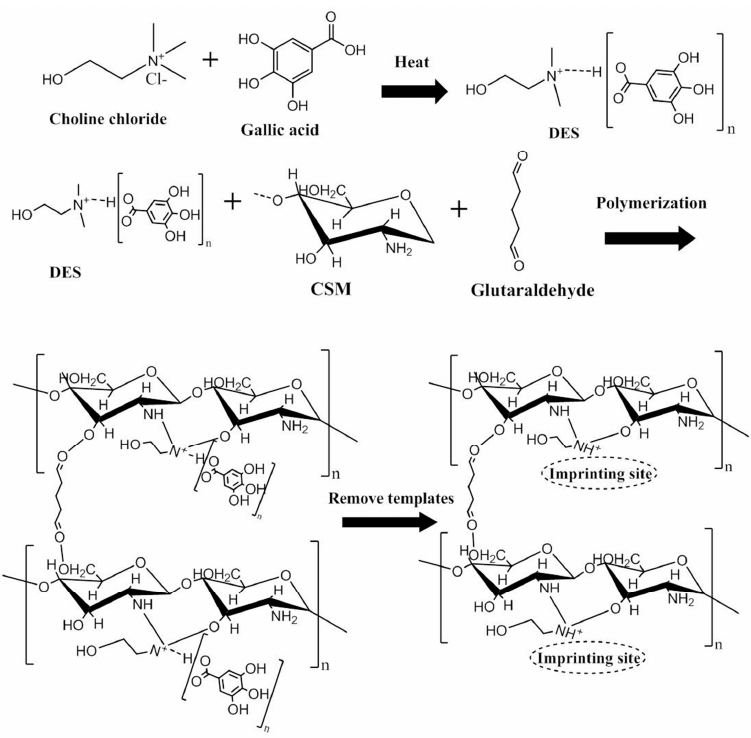
Figure 1. Schematic diagram of the preparation of hydrophilic molecularly imprinted chitosan (HMICS) with deep eutectic solvents (DES).